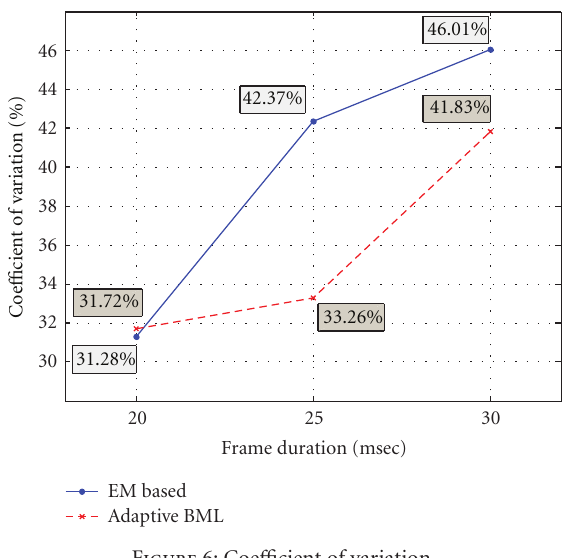
Figure 6: Coe ffi cient of variation. Figure 7: Number of components.